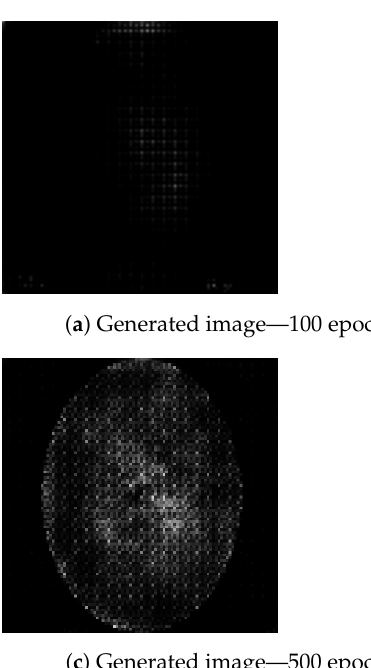
Figure 5. Comparison of images representing healthy mucosa generated by GAN executed for: 100 ( a ), 250 ( b ) 500 ( c ) and 1000 ( d ) epochs